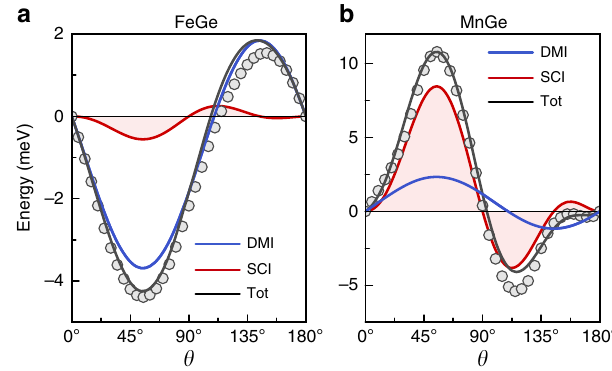
Fig. 5 Spin-orbit mediated interactions in B20 germanides. Comparing in a FeGe and b MnGe the spin-orbit-induced energy change for ϕ ¼ 45 (cid:4) between the fi rst-principles calculations (circles) and the model fi t (lines), resolved in terms of antisymmetric exchange (DMI) and spin-chiral interaction(SCI).